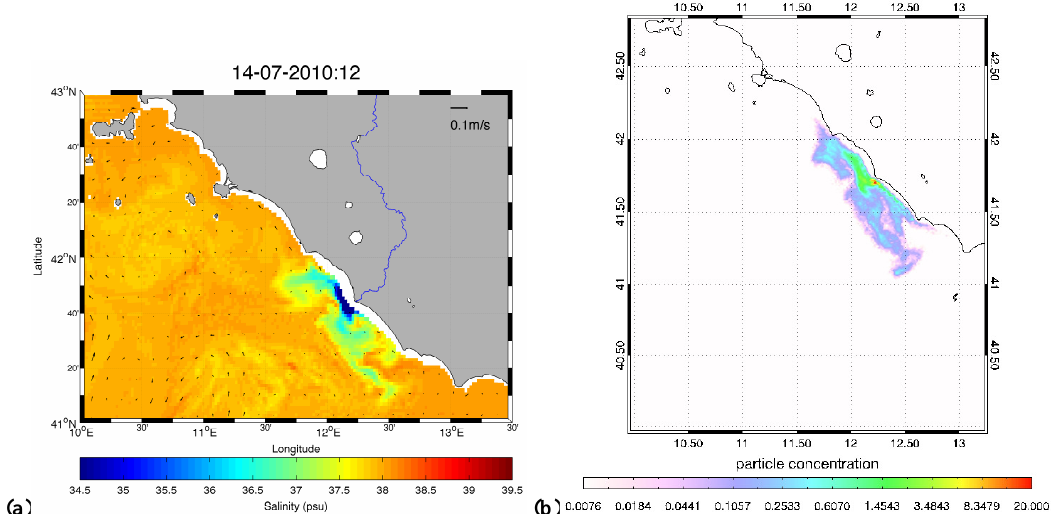
Fig. 8. (a) 14 July 2010, salinity at − 5m. (b) 14 July 2010, map of pollutant dispersion; units (gm − 2 ), logarithmic Fig. 8a. 14 July 2010, salinity at –5 m. Fig. 8b. 14 July 2010, map of pollutant dispersion; units ( gm − 2 ), logarithmic scale.